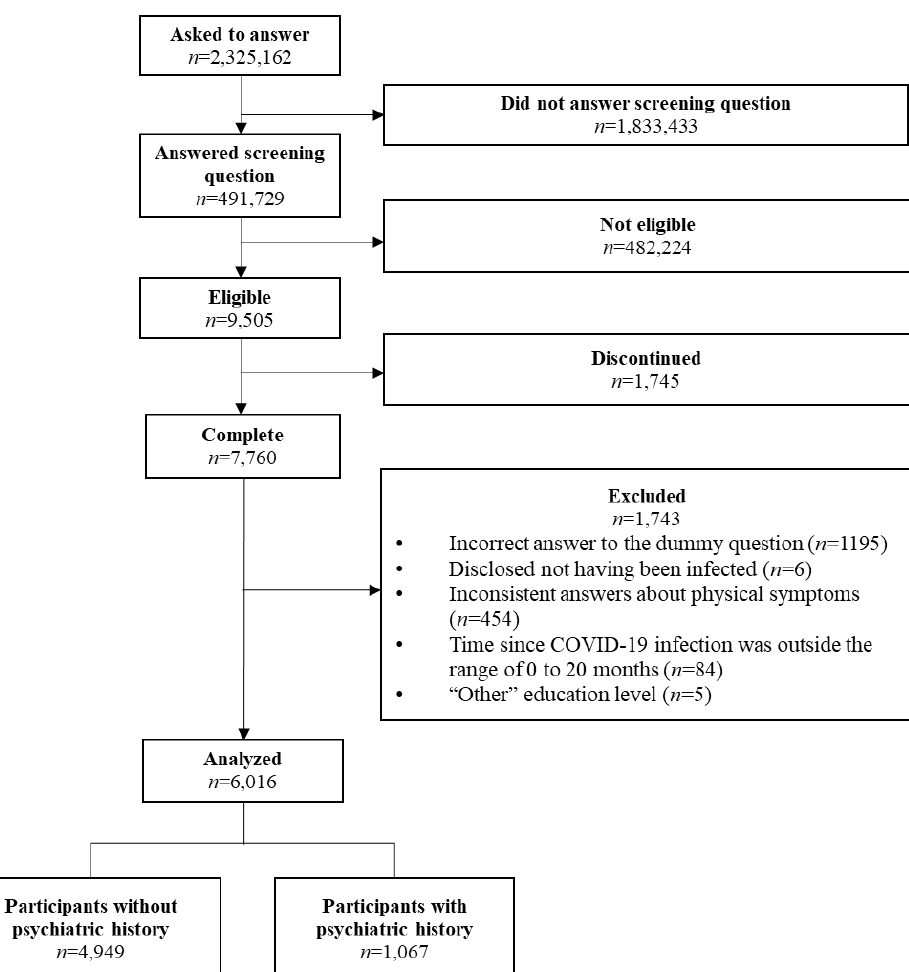
Figure 1. Flow chart of the participants from recruitment to analysis. Table 1. Participant